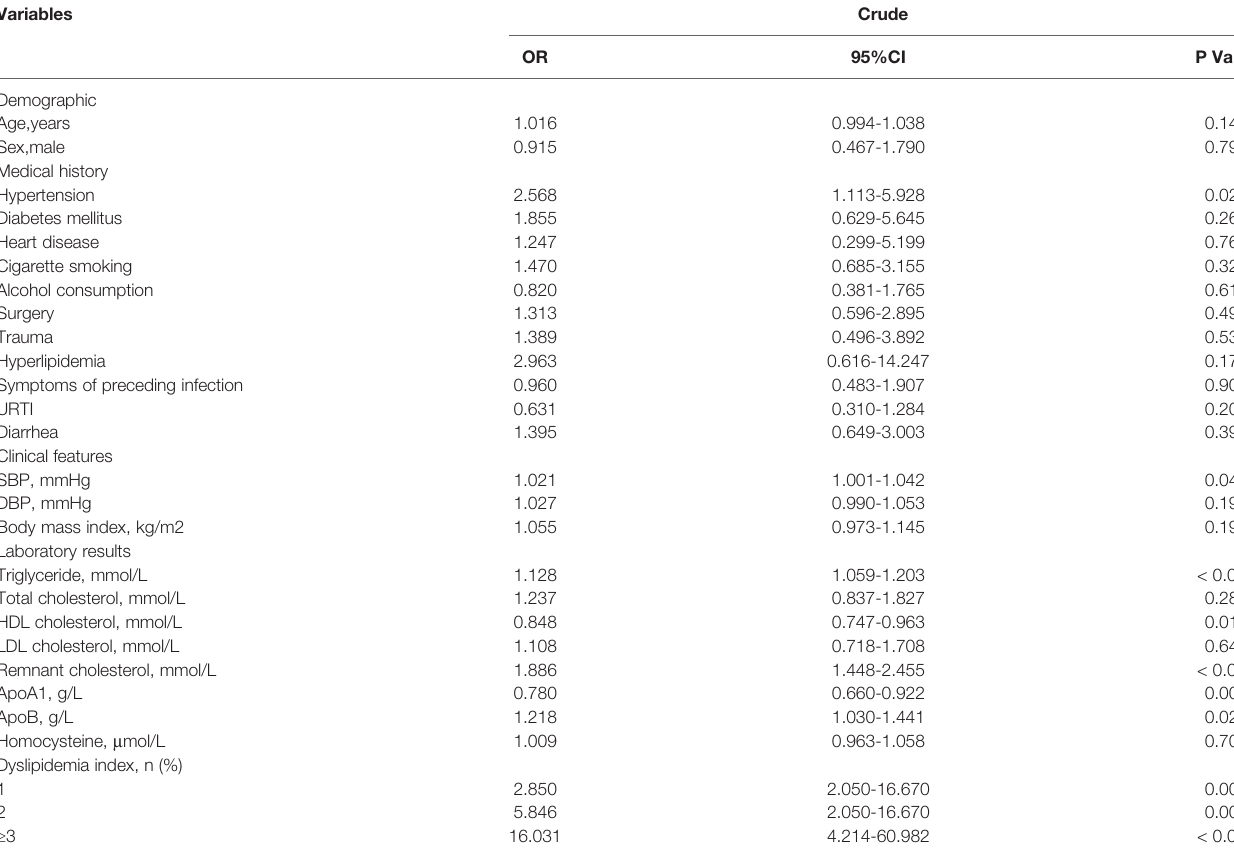
TABLE 2 | Univariate Logistic Regression Analysis of Predictors for Severe GBS.